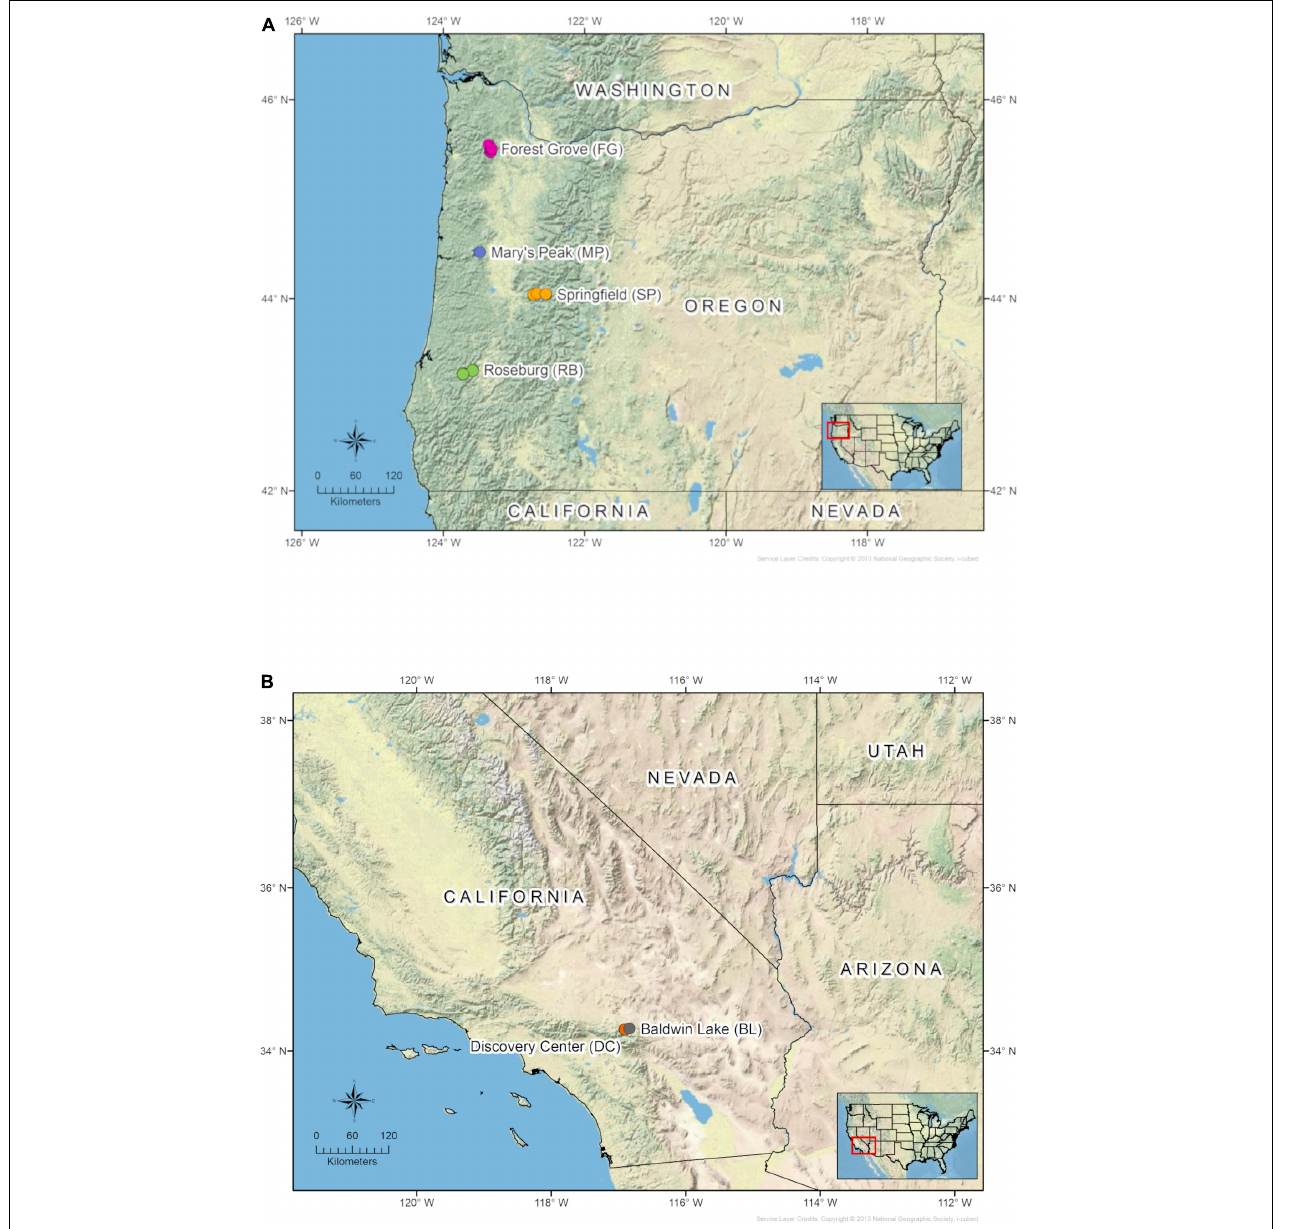
FIGURE 1 | Maps of sampling locations in (A) Oregon Douglas-fir plantations, and (B) California pinyon pine stands.